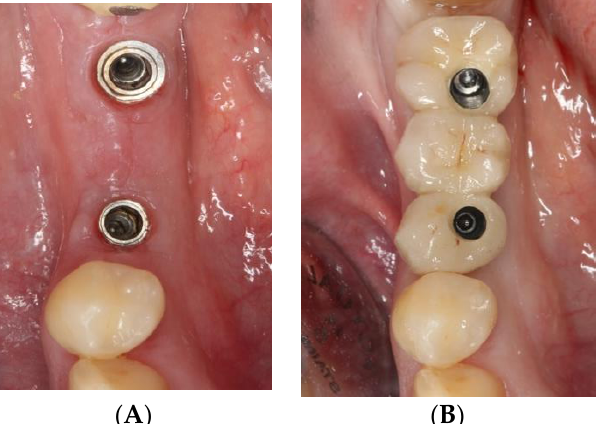
Figure 7. ( A ) two bone level implants KOHNO in position 3.5 and 3.7, ( B ) fixed partial prosthesis (3 pieces) on 2 bone level implants KOHNO.